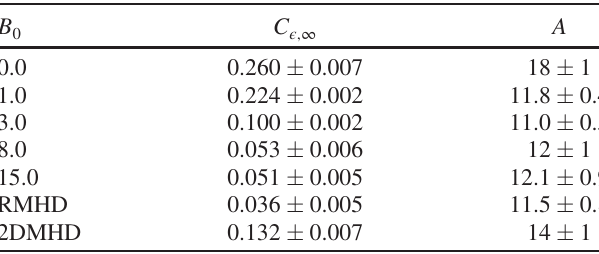
TABLE II. Summary of the asymptotic nondimensional dis- sipation rate C ϵ ; ∞ from different simulation sets of Table I and sets of RMHD and 2DMHD runs. Additionally, we report the value of the constant A in Eq.